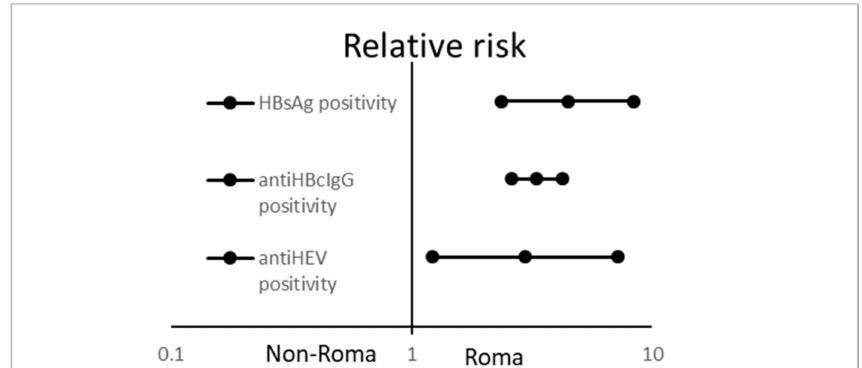
Figure 3. Relative risk with 95% confidence intervals of hepatitis B and hepatitis E serological markers positivity in Roma participants, compared with the non-Roma population.